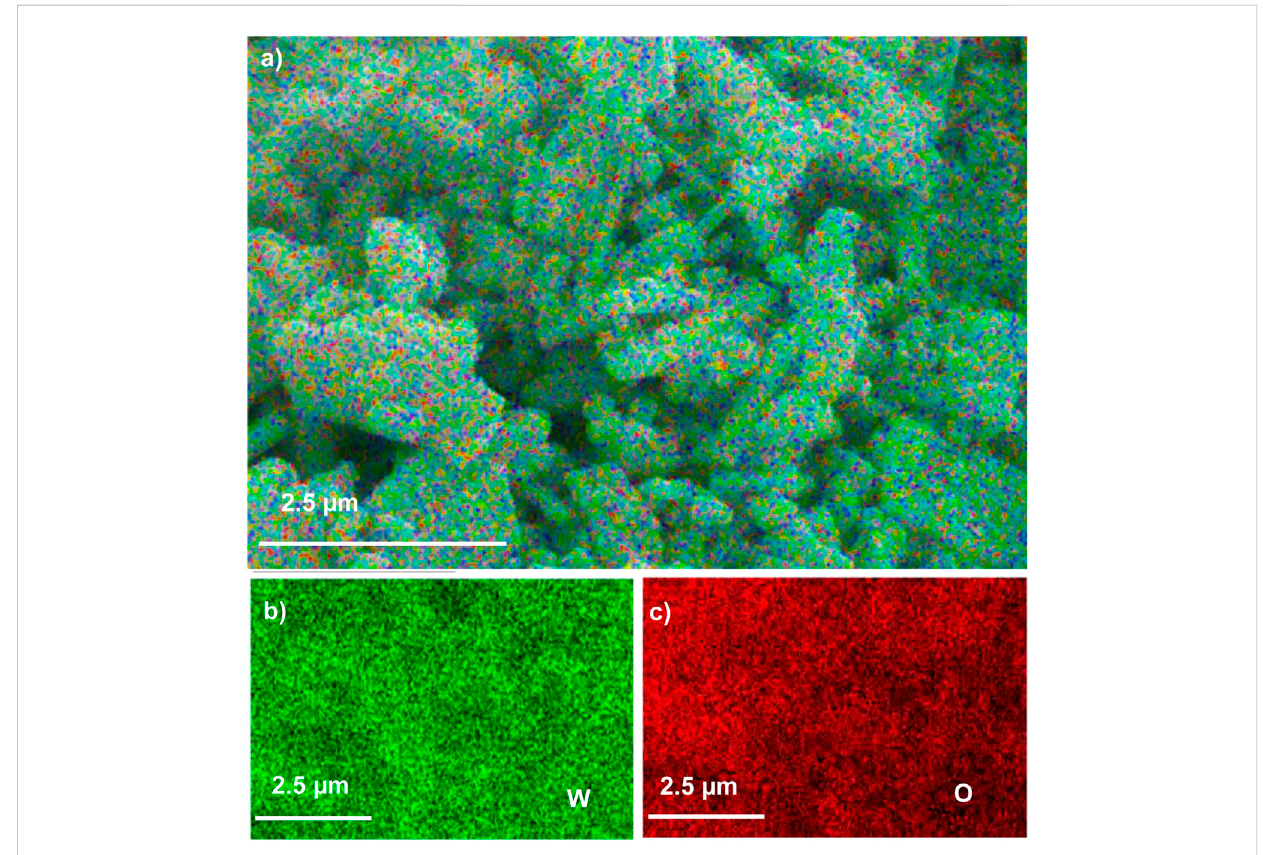
FIGURE 3 The EDX micrograph of (A) WO 3 -HNO 3 sample, and its corresponding elements mapping of (B) W, and (C) O, based on SEM images of WO 3 -HNO 3 .